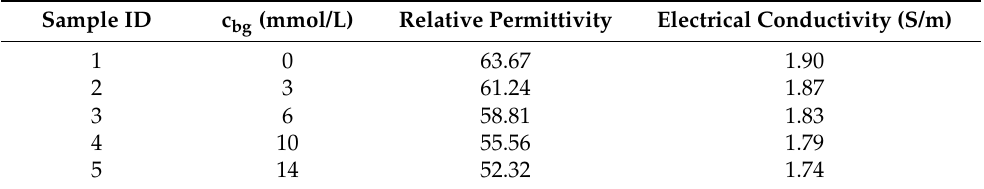
Table 1. Calculated values of dielectric properties of liquid phantoms at 2 GHz and room temperature, according to